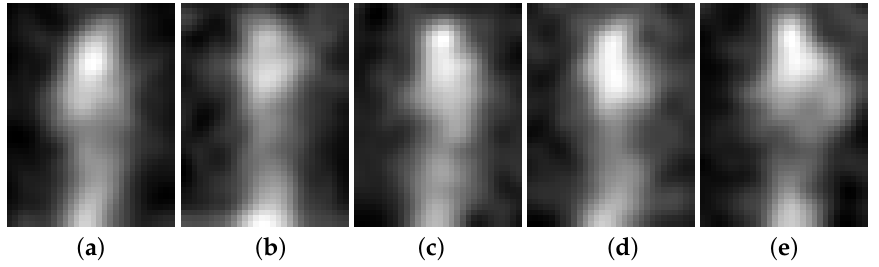
Figure 13. Input Images for Pose Detection: ( a ) Standing; ( b ) Raising hand; ( c ) Arms on hips; ( d ) Crossing hands; ( e ) Hands on